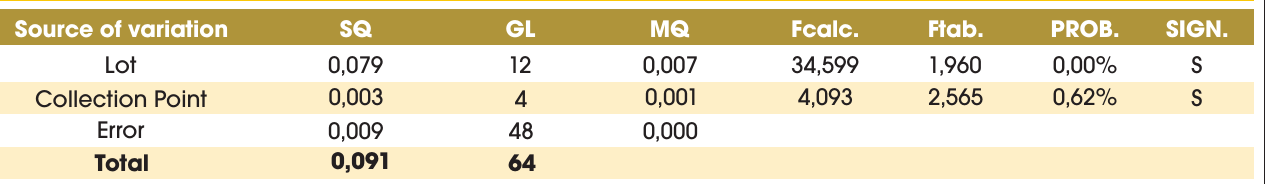
Table 6 – Variance analysis for coarse